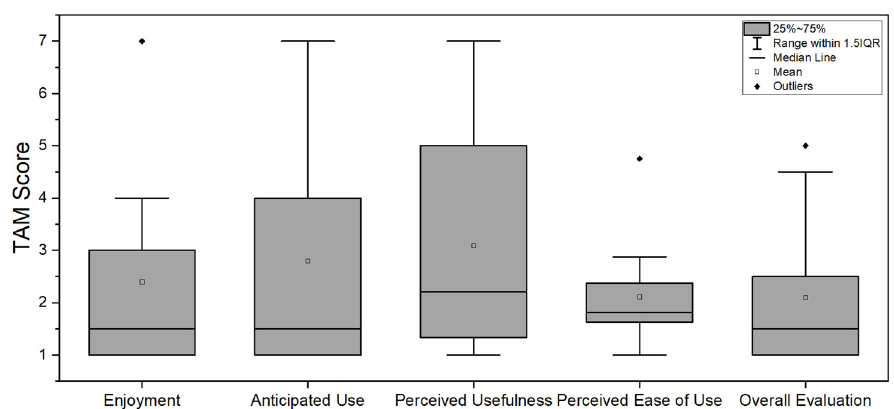
Figure 2. Summary of results of all TAM categories. The boxplot shows the mean answer for every category. Patients could react to the statements on a scale from 1 to 7. A lower score was associated with a good acceptance of AGS. The mean score for all categories was between the neutral and the positive associated answer. AGS: adaptive gait support; TAM: technology acceptance model.